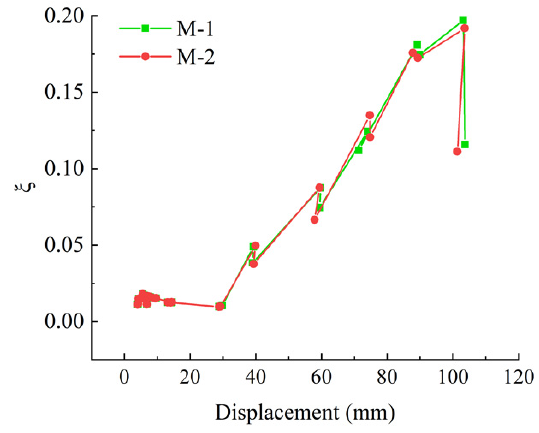
Figure 23. The equivalent viscous damping coefficient of M-1 and M-2.